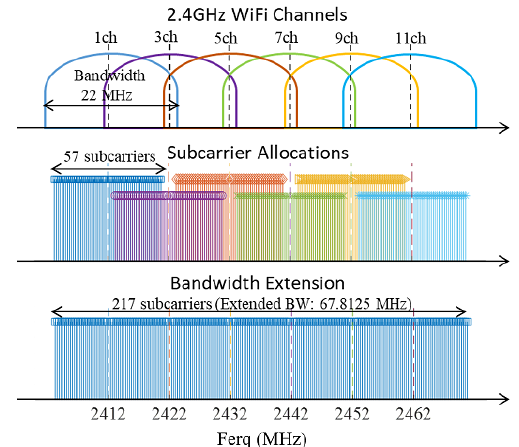
Figure 4. Bandwidth extension by six-channel bonding.